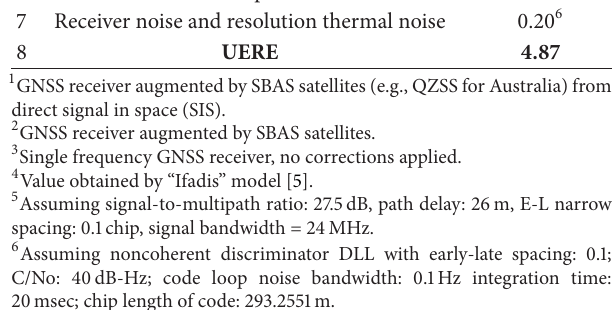
FRPA pattern: simulated FRPA pattern: cosine with interference FRPA pattern: simulated with interference CRPA pattern Figure 16: Horizontal accuracy CDF curve − 24/24GPS constella- tion and 1RF interfering